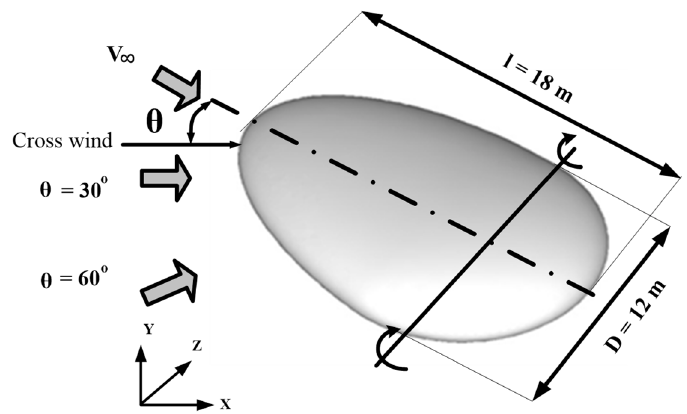
Figure 11. Schematic diagram with various crosswind angles for the free stream direction. Figures 12 and 13 depict crosswind angles of θ = 30 ◦ and 60 ◦ with increasing angles of attack from α = 0 ◦ to α = 90 ◦ , and the impact of these angles on variation of the lift and drag forces. When the hybrid airship model is subjected to a crosswind angle of θ = 30 ◦